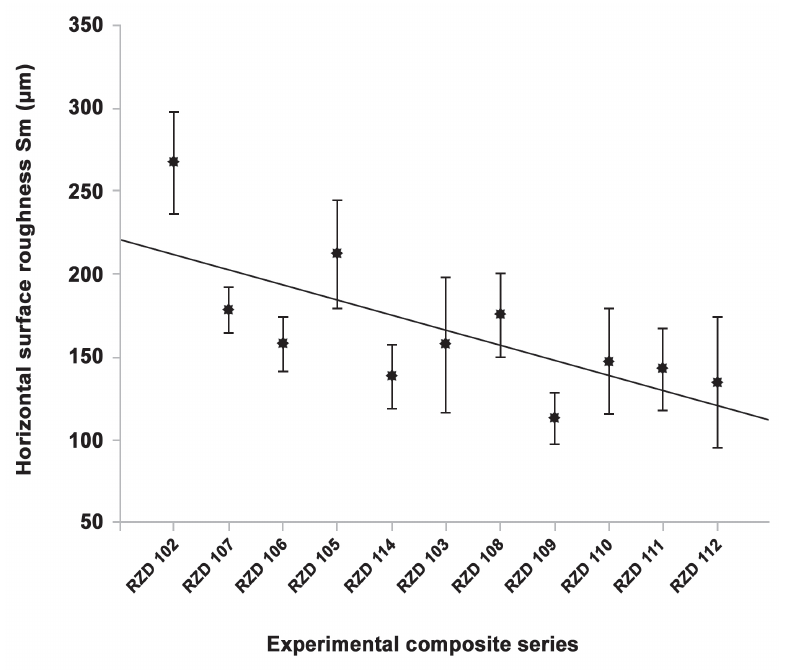
( µ m) regression of the experimental composite series a